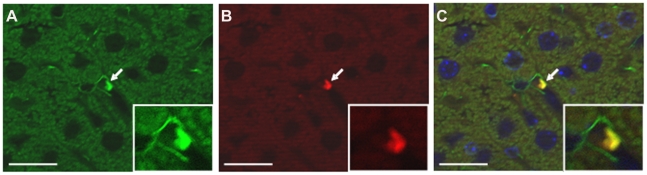
Co-localization of GFP expression with expression of the HSC marker desmin.Immunohistochemistry was performed on sections of liver from collagen-GFP mice using antibodies to the HSC marker desmin (A) and GFP (B). Merged image shows colocalization of desmin and GFP expression (C). DAPI (blue) staining of nuclei is also shown in the merged image. Micrographs are at 40× magnification. Scale bars, 15 µm. Arrows point to a hepatic stellate cell. Insets show magnified view of one HSC.